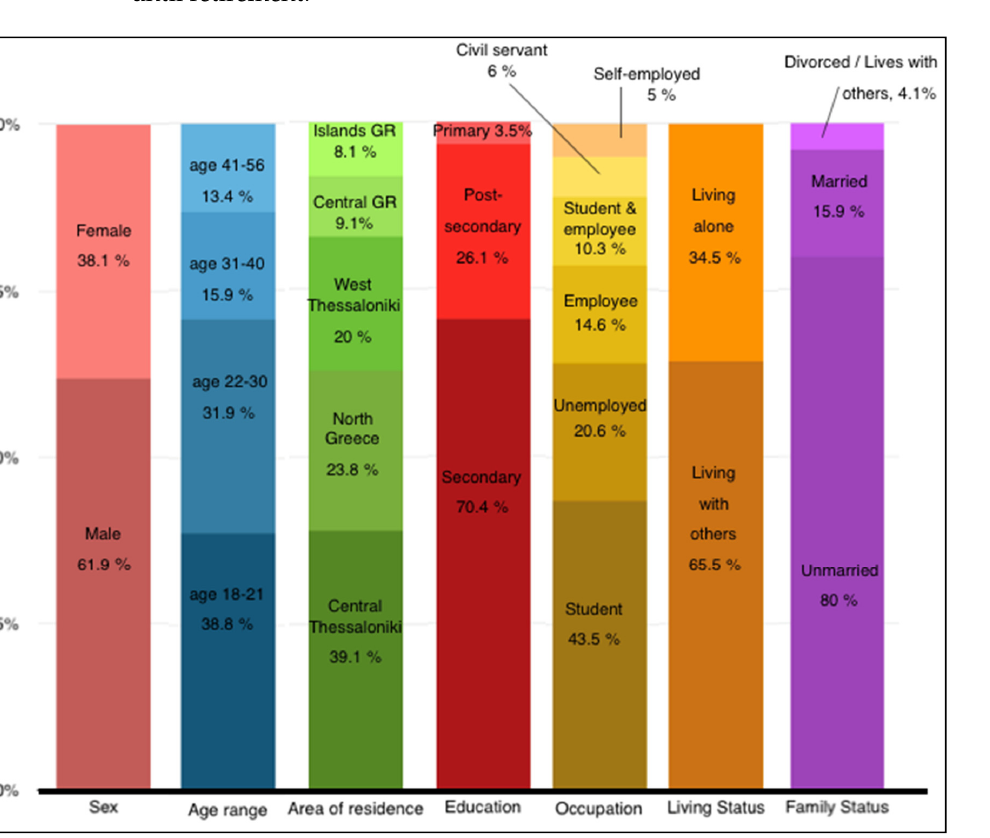
Figure 1. Socio-demographic characteristics of the participants that were assessed for SLD at the OSDDL of the 1st Psy- chiatric Clinic, “Papageorgiou” General Hospital of Thessaloniki, Greece. Psychiatric Clinic, “Papageorgiou” General Hospital of Thessaloniki,